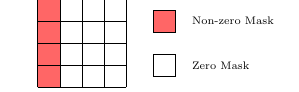
Figure 7: Linear mask Γ for AES-PRF 2 , 8 .